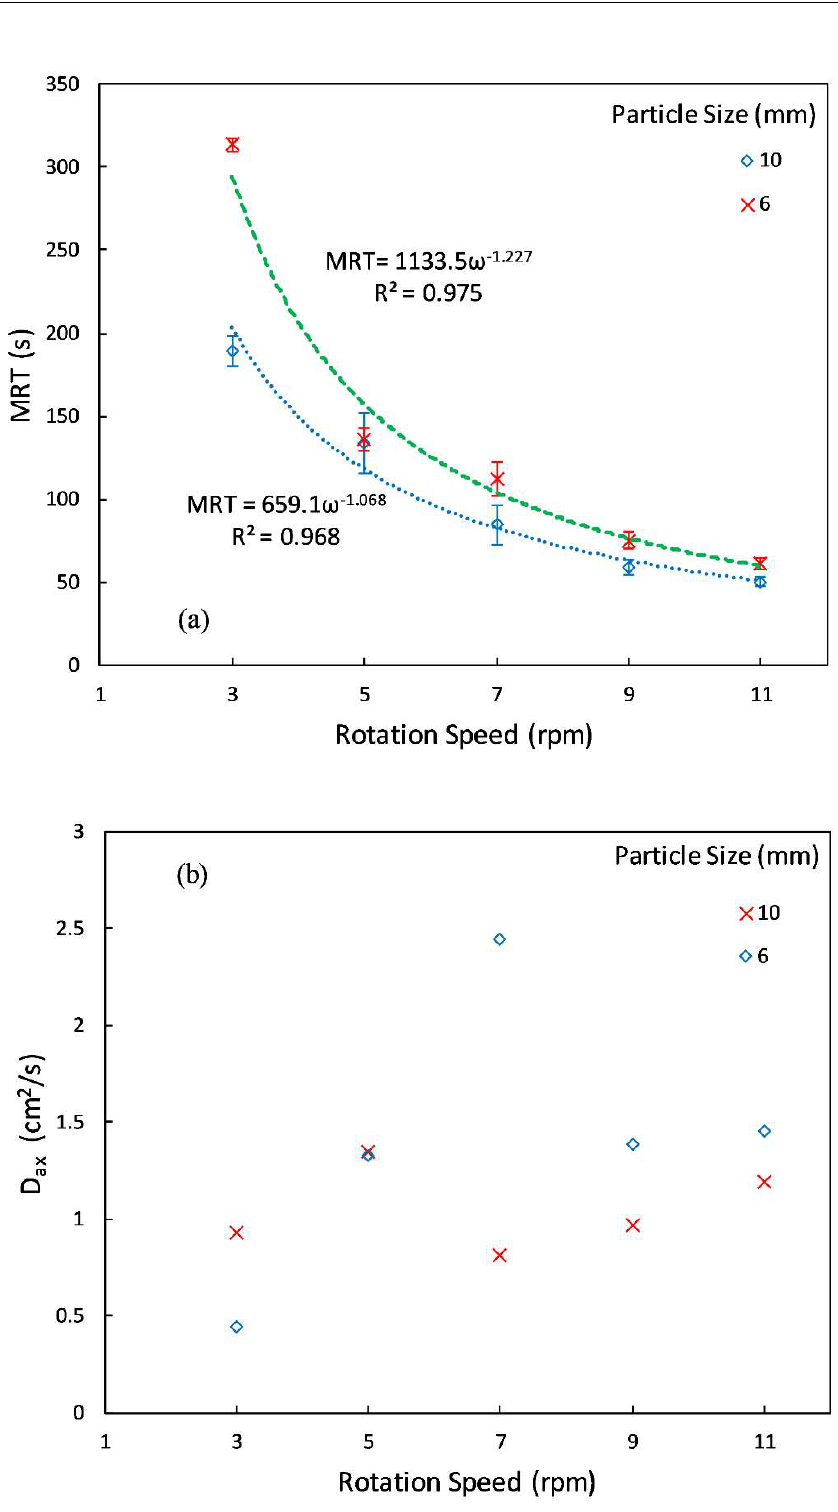
Figure 9. Effect of particle size on ( a ) MRT ( b ) axial dispersion coefficient at 3 ◦ and 0.72 cm 3 /s Figure 9 . Effect of particle size on ( a ) MRT ( b ) axial dispersion coefficient at 3° and 0.72 cm 3 /s for 6 for 6 mm and 10 mm mm and 10 mm cube.